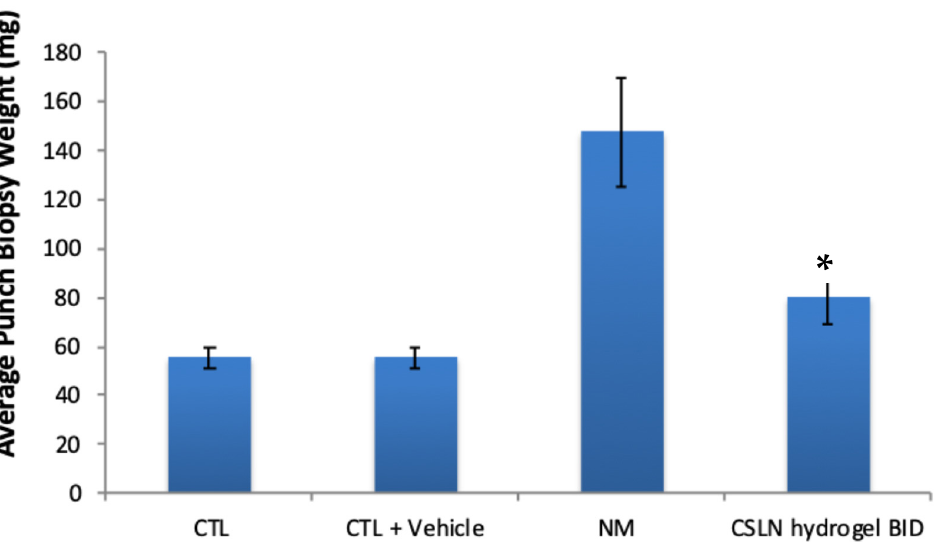
Figure 6. Average punch biopsy weight for different groups, three days post nitrogen mustard exposure. CTL = naïve control, CTL+vehicle = only vehicle applied on control skin; NM = nitrogen mustard treatment; and BID = twice a day. * Significant decrease in inflammation in comparison to nitrogen mustard group.